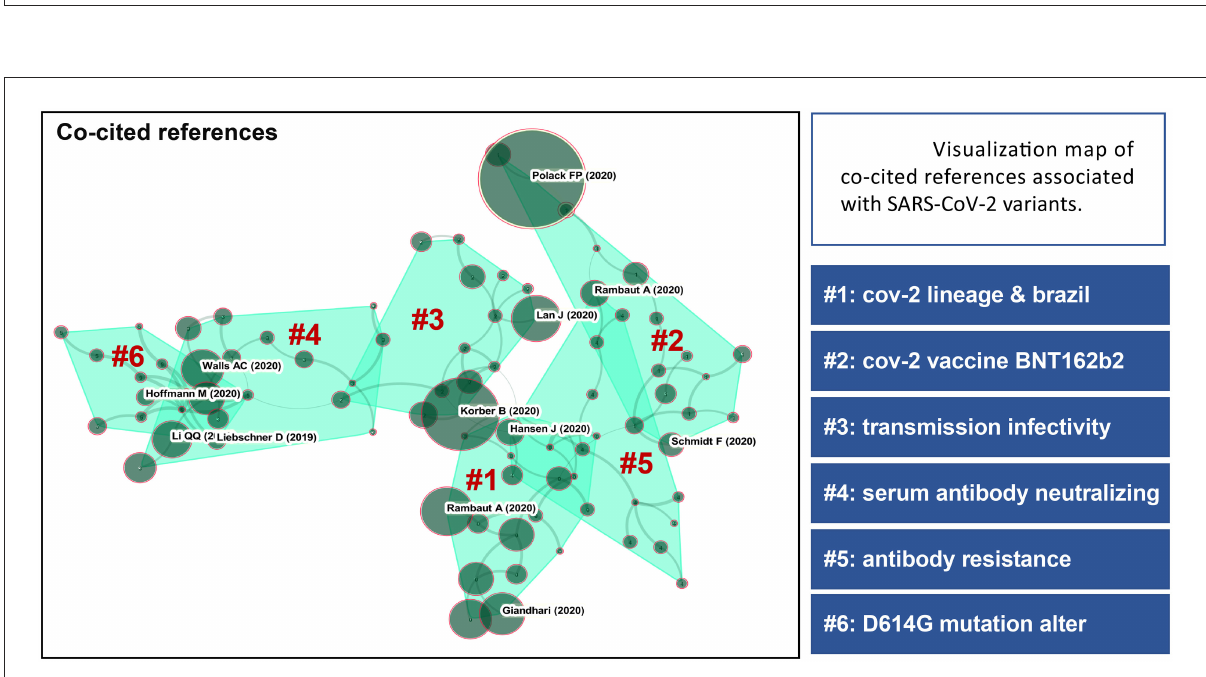
FIGURE5 Visualization map of co-cited references associated with SARS-CoV-2 variants and corresponding clusters based on research direction. The size of the circles indicates the number of co-citations. Lines between categories indicate cross-linkages between study